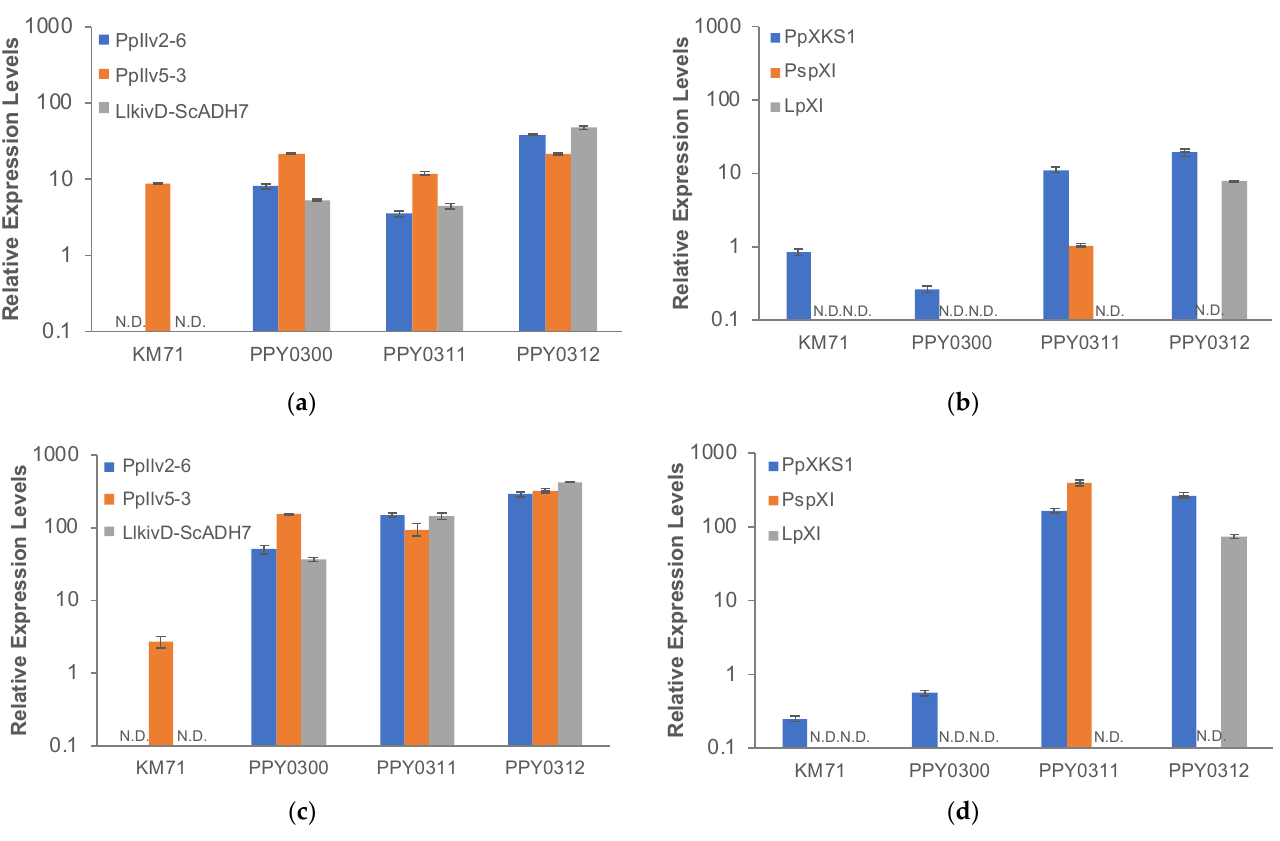
Figure 6. RT-PCR analysis of xylose utilization and isobutanol pathway genes of engineered strains in a sugarcane trash medium. ( a ) Expression of PpIlv2_codon optimized , PpIlv6_codon optimized , PpIlv5 , PpIlv3 , LlkivD , and ScADH7 of engineered strains in minimal medium with sugarcane trash hydrolysates with a total sugar content of 1.5%; ( b ) expression of PpXKS , PspXI, and LpXI of engineered strains in minimal medium with sugarcane trash hydrolysates with a total sugar content of 1.5%; ( c ) expression of PpIlv2_codon optimized , PpIlv6_codon optimized , PpIlv5 , PpIlv3 , LlkivD, and ScADH7 of engineered strains in minimal medium with sugarcane trash hydrolysates with a total sugar content of 2.0%; ( d ) expression of PpXKS , PspXI, and LpXI of engineered strains in minimal medium with sugarcane trash hydrolysates with a total sugar content of